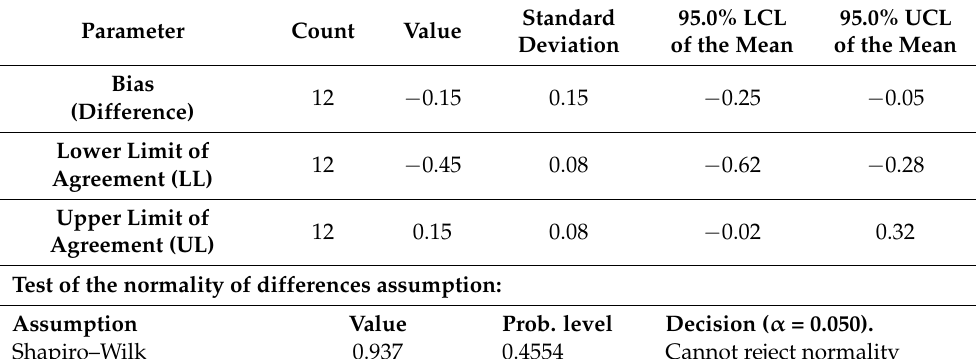
Table 4. Bland–Altman analysis: Bias and limits of agreement for the two methods. Limits